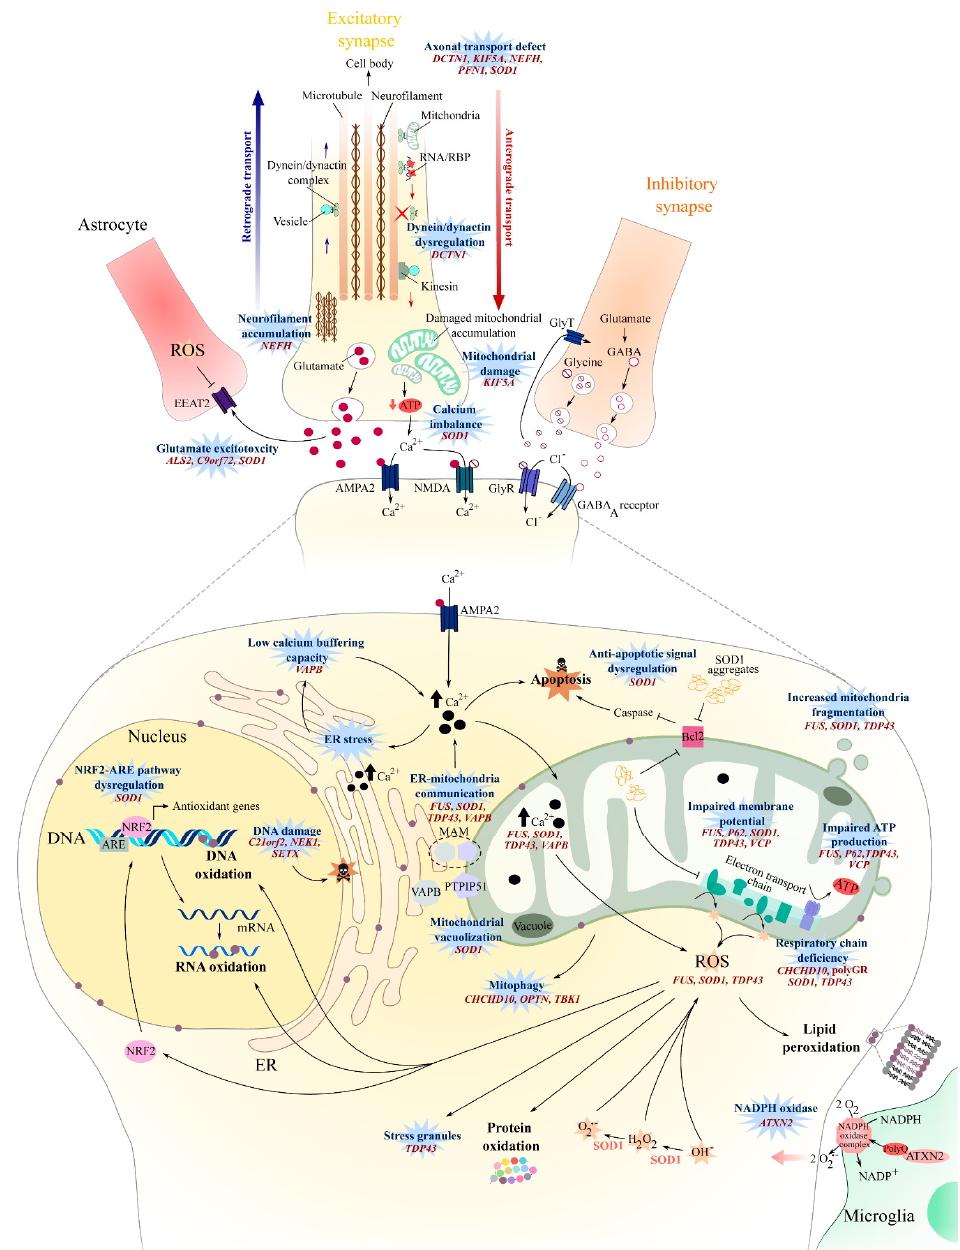
Figure 1. Oxidative stress, mitochondrial dysfunction, axonal transport, and glutamate excitotoxicity in amyotrophic lateral sclerosis (ALS). An increase in oxidative stress can result from defects in detoxifying pathways. Such defects include the loss of SOD1 function, aberrant DNA damage repair machinery, or a decrease in expression of antioxidant genes affecting the NRF2-ARE pathway. Oxidative stress can also be increased by the stimulation of ROS production via increased NADPH oxidase activity or from disrupted mitchondrial respiratory chain activity. Mitochondrial activity can be affected by several ALS mutations, such as those leading to the accumulation of protein aggregates, or to decreased mitochondrial biogenesis and transport, or to increased cytosolic Ca 2 + (as observed when glutamate receptor activity is stimulated or when the Ca 2 + -buffering capacity is decreased). Consequently a disruption of the mitochondrial respiratory chain will lead to an increase in ROS production and, thus, to an accumulation of oxidized proteins, lipids, DNA, and RNA. Oxidative damage occurring over time may then stimulate apoptotosis and, thus, cell death. Defective axonal transport affects not only the mitochondria but, also, the transport of other proteins and RNA, with consequences on the axon structure and function being accompanied by neurofilament